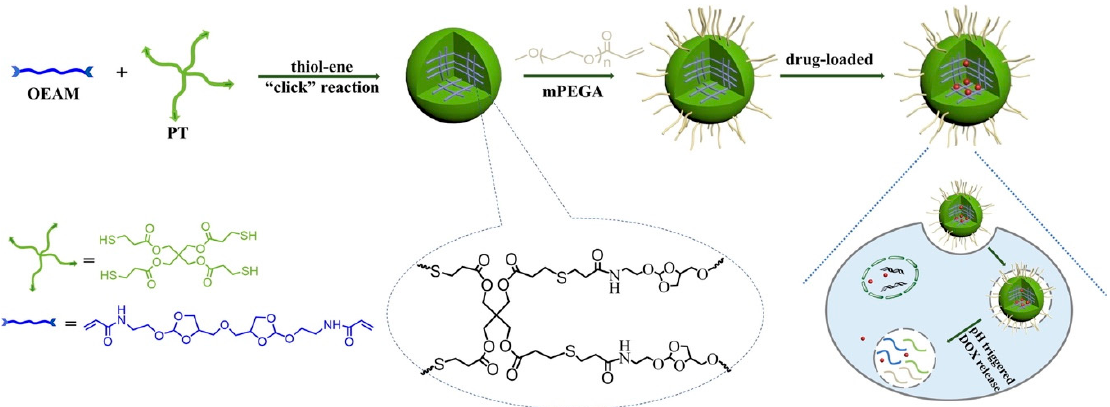
Figure 2. The scheme for synthesis of pH-sensitive nanogels via thiol-ene“click” reaction, and the mechanism for drug loading and intracellular drug release. Adapted from (Journal of Colloid and Interface Science. 2017, 508, 282–290). Copyright (2020) with permission from Elsevier Science.